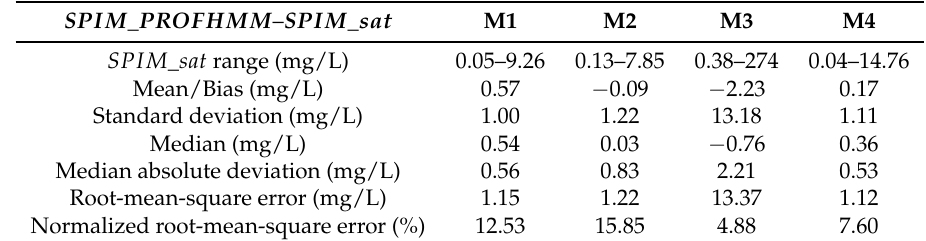
Table 2. The error estimated for surface suspended particulate inorganic matter (SPIM) between PROFHMM and satellite for four